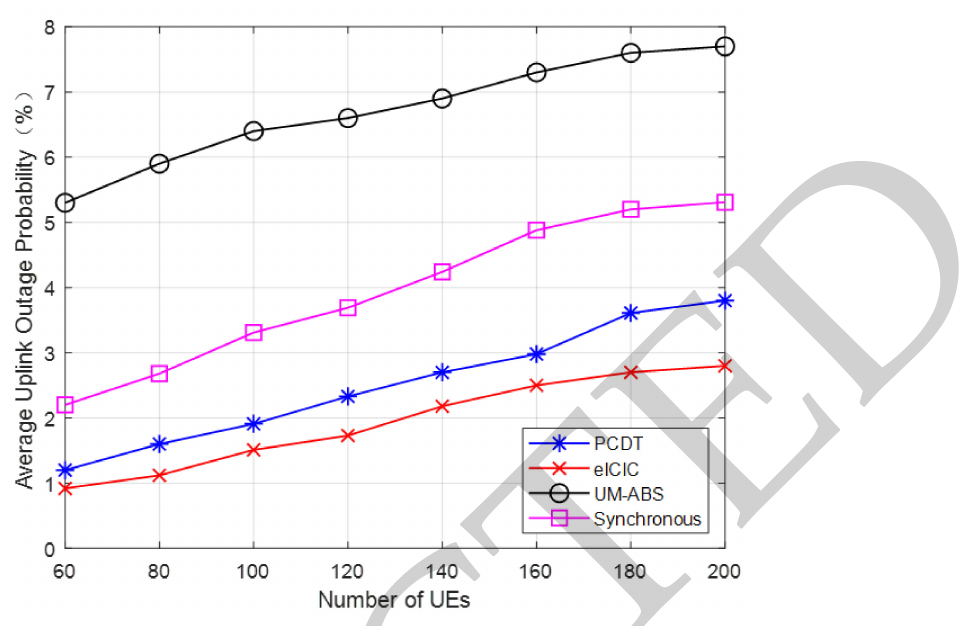
Figure 10. The comparison on the average uplink outage